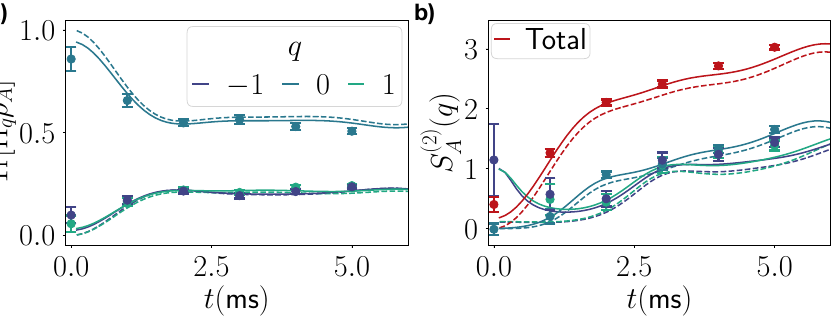
Figure 8: Experimental demonstration of symmetry-resolved purification in a trapped ion quantum simulator, using data obtained in the context of Ref. [ 29 ] . We consider a system of N = 10 spins, with subsystems A = [ 4,5,6,7 ] and B = [ 1,2,3,8,9,10 ] . In panels a) and b), the symmetry-resolved populations and Rényi entropies of vari- ous magnetization sectors q = 0, ± 1 of the reduced density matrix ρ function of time (see Fig. 2 for symmetry-resolved purities). Error bars have been calculated with Jackknife resampling. In panel b), data for the magnetization sector q = 1 at J t = 0 has been omitted due to large errorbars, resulting from small popu- lations. Lines are numerical simulations of unitary dynamics (dashed) and including decoherence (solid) as decribed in the